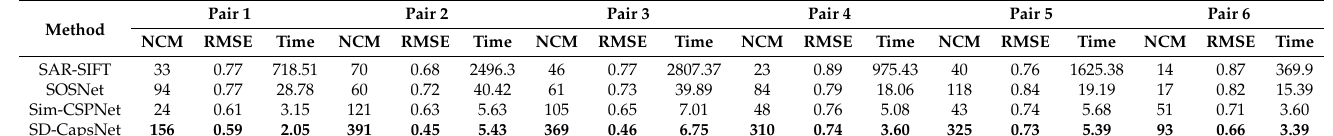
Figure 13. The feature descriptor matching results with different methods for pair 2. ( a ) SAR-SIFT. ( b ) SOSNet. ( c ) Sim-CSPNet. ( d ) Our proposed SD-CapsNet. Table 5. Comparison of the NCM, RMSE, and Time (s) of Six SAR Image Pairs with Different Methods.